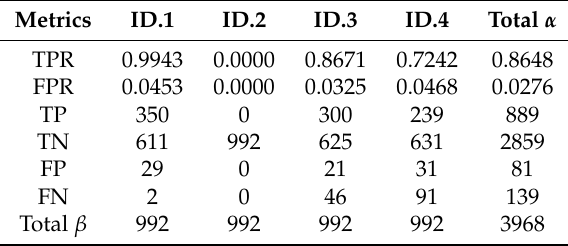
Table 5. Recognition results of the proposed